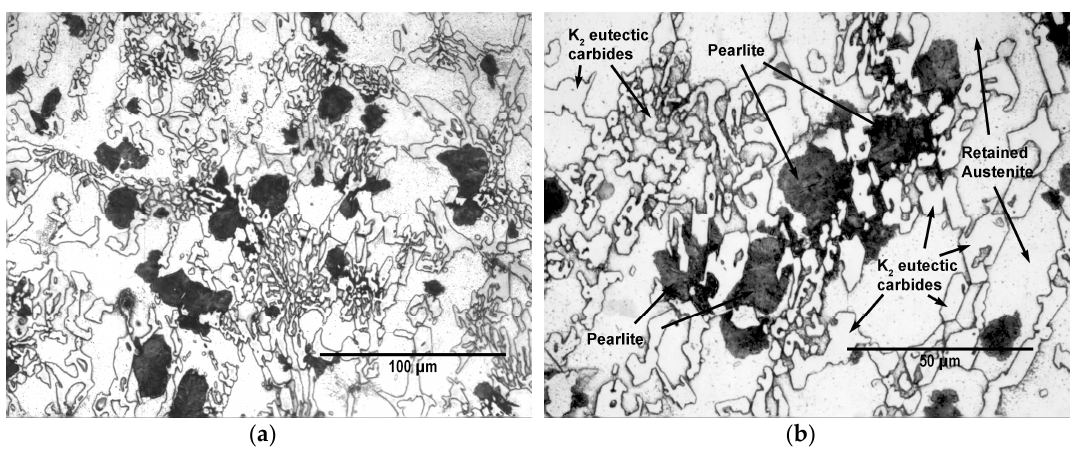
Figure 1. As-cast Microstructure: ( a ) ×500 magnification; ( b ) ×1000 magnification.